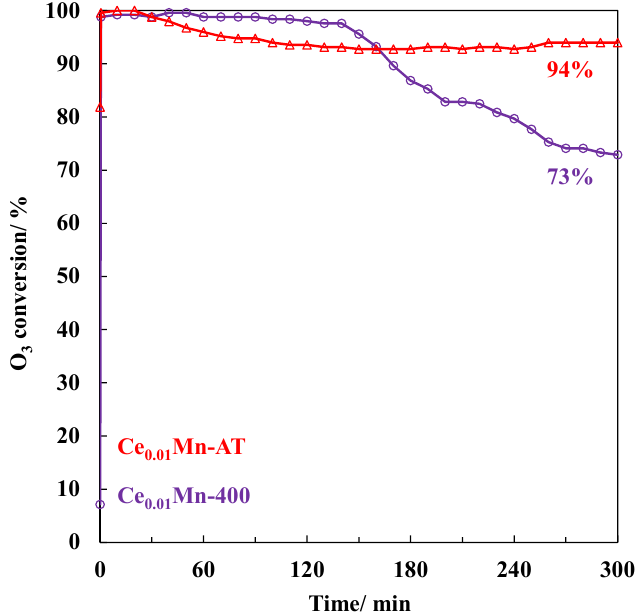
Figure 5. Ozone conversion in Ce 0.01 Mn-400 and Ce 0.01 Mn-AT ([O 3 ] = 300 ppmv, GHSV = 1200 L/(g cata · h); RH = 0.7%).